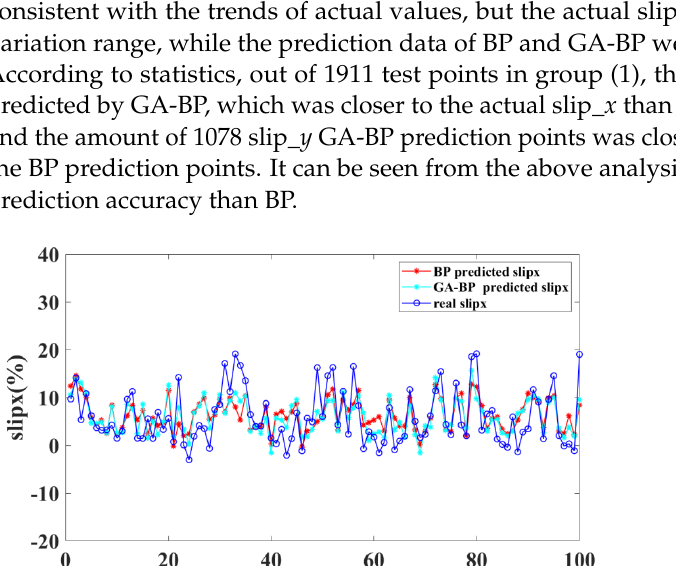
Figure 11. BP predicted slip_ x , GA-BP predicted slip_ x, and real slip_ x (part of the results).